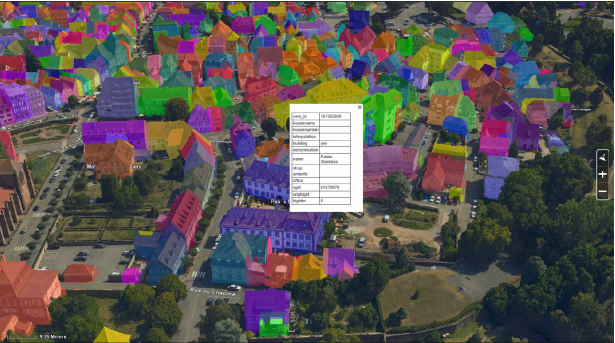
Figure 12: Colorized Database information from GIS layers combined with the 3D model The combination of 3D GI Systems for public use will increase also the use of the 3D models. As already in tourist information systems applied, these models will be part of wider information systems that also will be acces- sible on mobile devices via internet. Virtual and real guidance through a city will be just one of the further